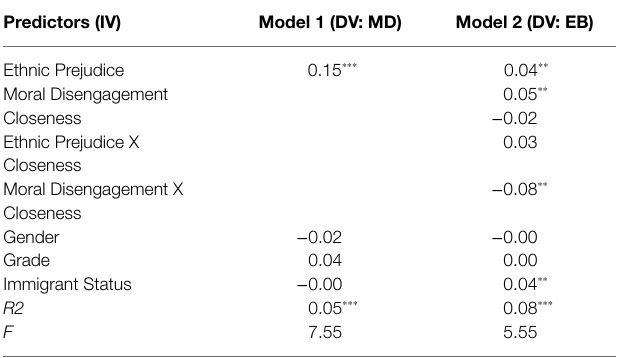
whether the interactions terms between closeness with teachers bullying. Bootstrapping with 5,000 resamples to compute